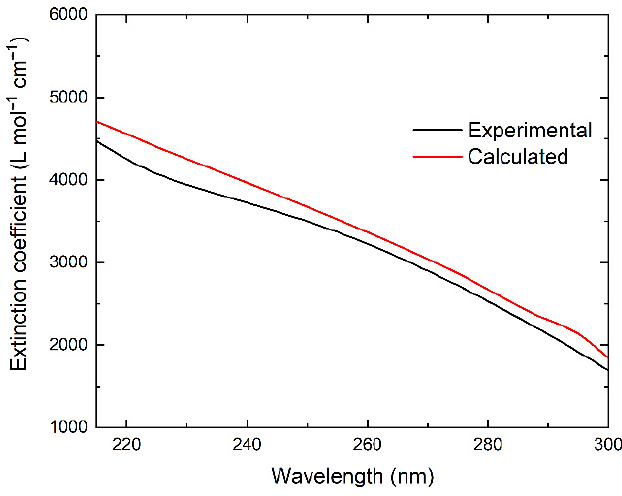
Figure 8. IBT absorption of silver nanoparticles in carbonate hydrosol (black line: experiment; red line: calculated from the dielectric permittivity of silver [39]).